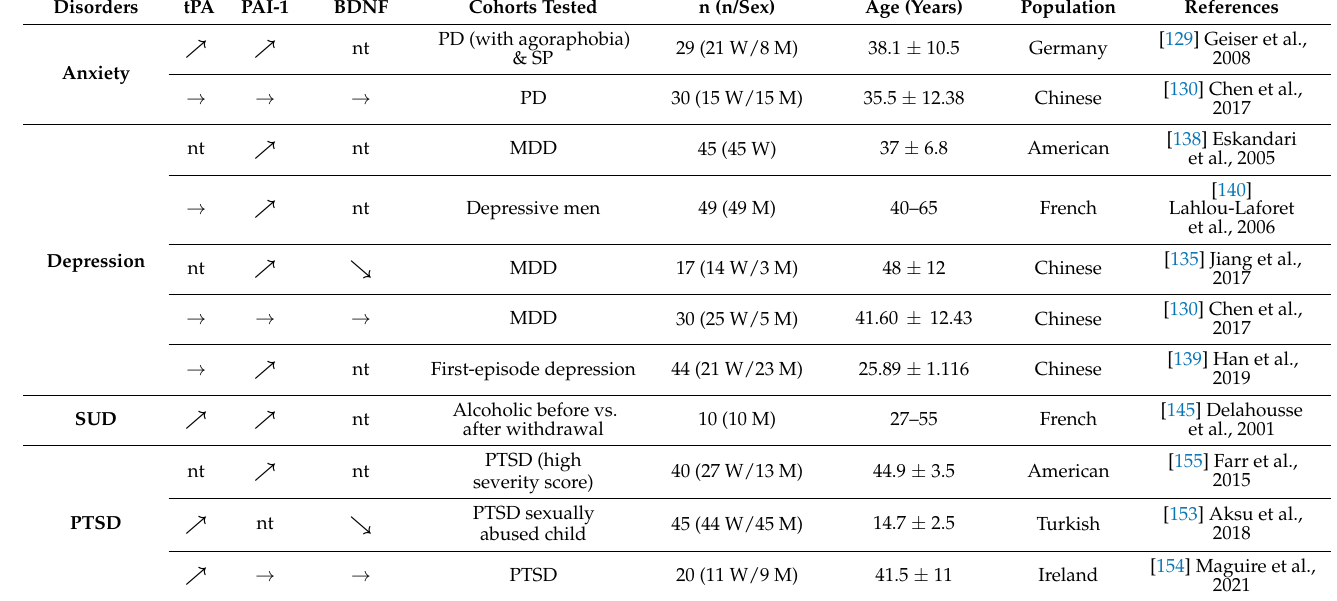
Table 2. Summary of findings from the literature concerning the tPA/PAI-1 system in the blood of human cohorts with stress-related psychiatric disorders. nt = not tested, nm = not mentioned, n = sample size, W = women, M = men, MDD = major depressive disorder, PD = panic disorder, SP = social phobia, SUD = substance use disorder, and PTSD = post-traumatic